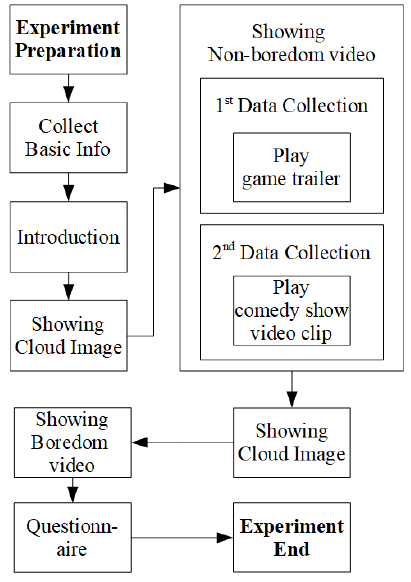
Figure 3. Protocol of data